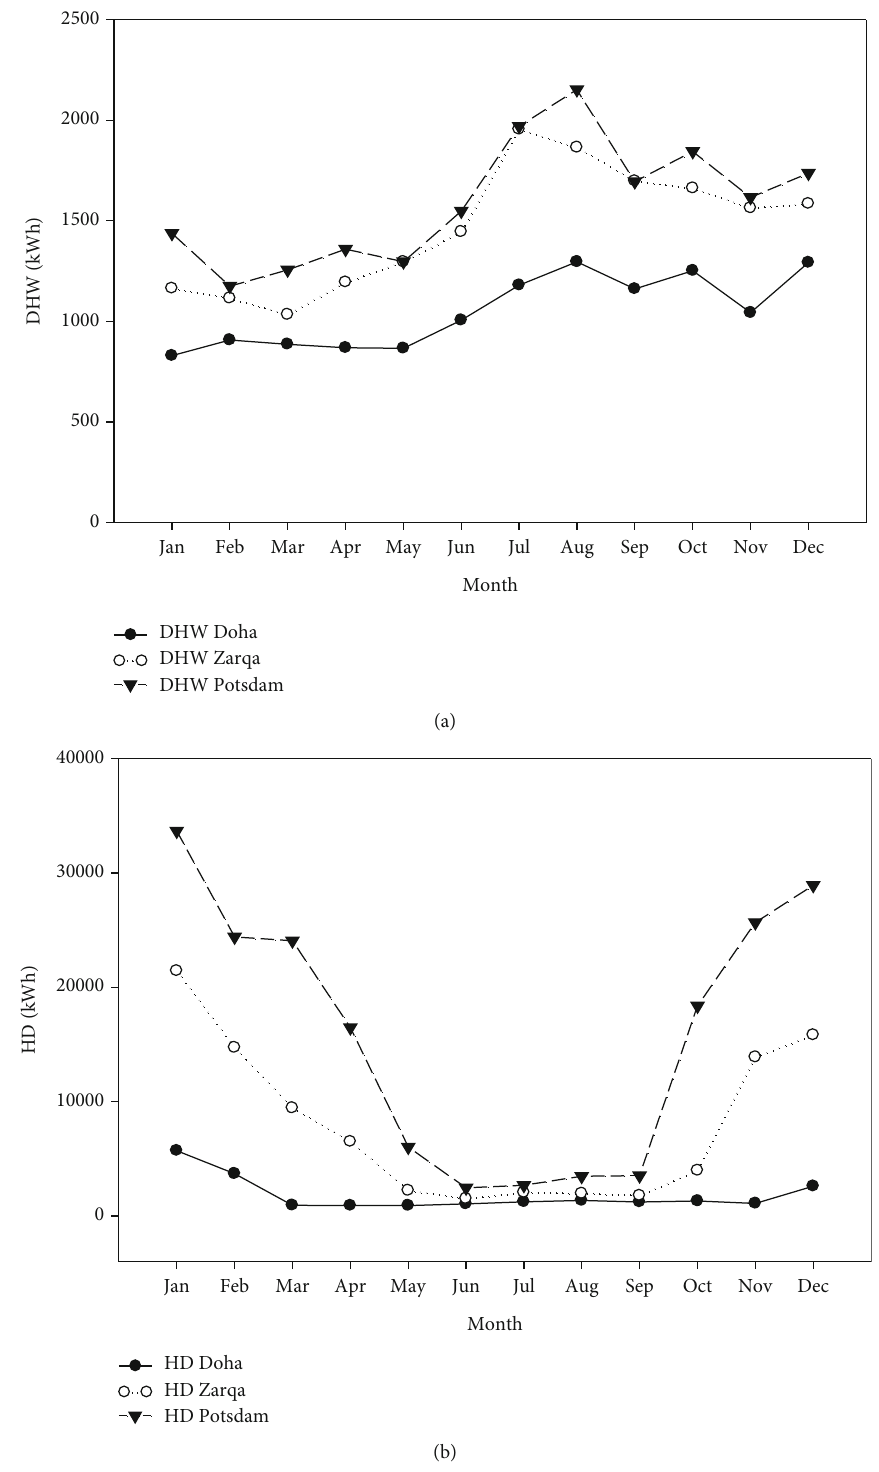
Figure 5: (a) Monthly DHW load for the three buildings (kWh) and (b) monthly total heating demand for the three buildings